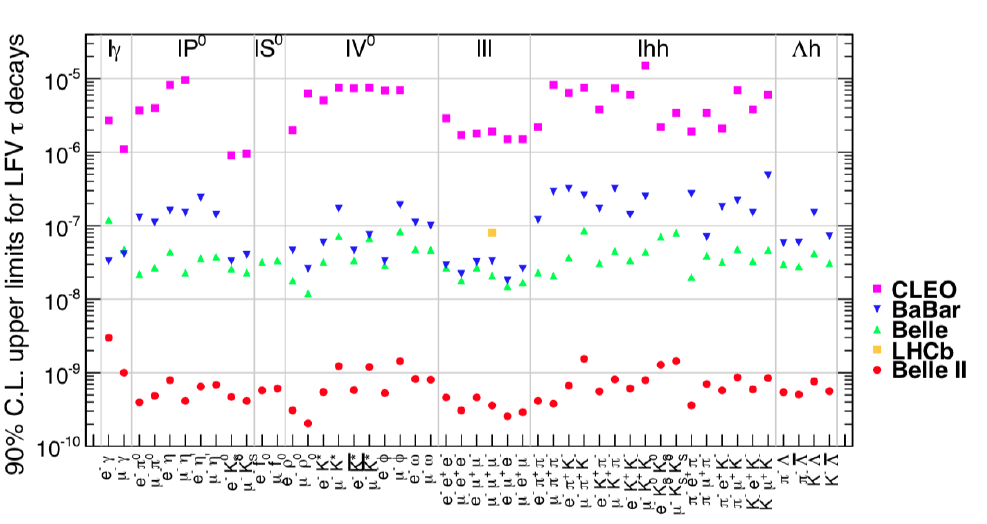
Figure 6: Current 90% C.L. upper limits for the branching fraction of LFV τ decays. Limits imposed by CLEO, BaBar, Belle and LHCb are showed. Additionally, prospects for limits to be imposed by Belle II are indicated with red circles, assuming an in- tegrated luminosity of 50 ab − 1 [ 6 ] . The last four decay modes also violates barion number